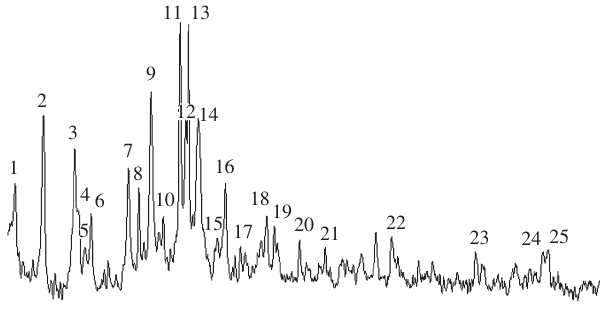
Figure 6. Mineralogical composition of the zeolite obtained by EDX.